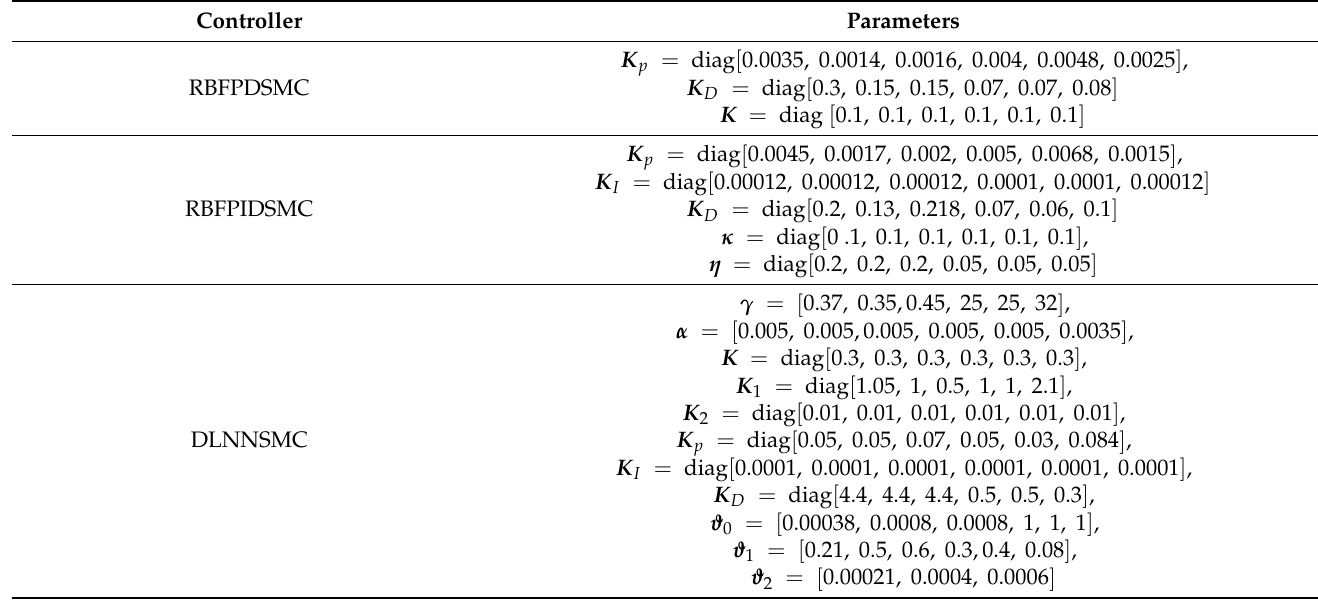
Table 2. Control parameters used in the